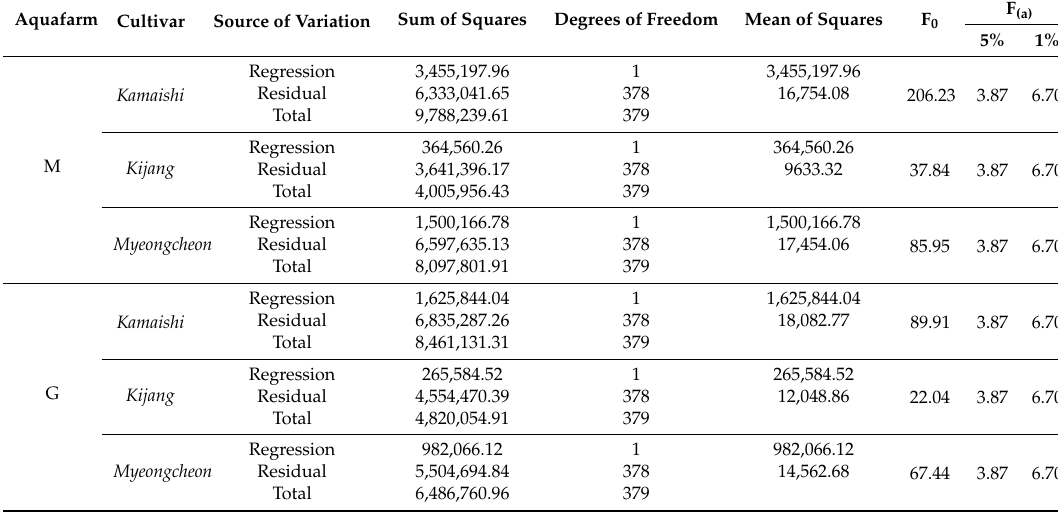
Table 4. Analysis of variance between blade lengths and blade weights of three U. pinnatifida cultivars at Myeongcheon (M) and Gyedo (G) aquafarms between January and May 2003. Aquafarm Cultivar Source of Variation Sum of Squares Degrees of Freedom